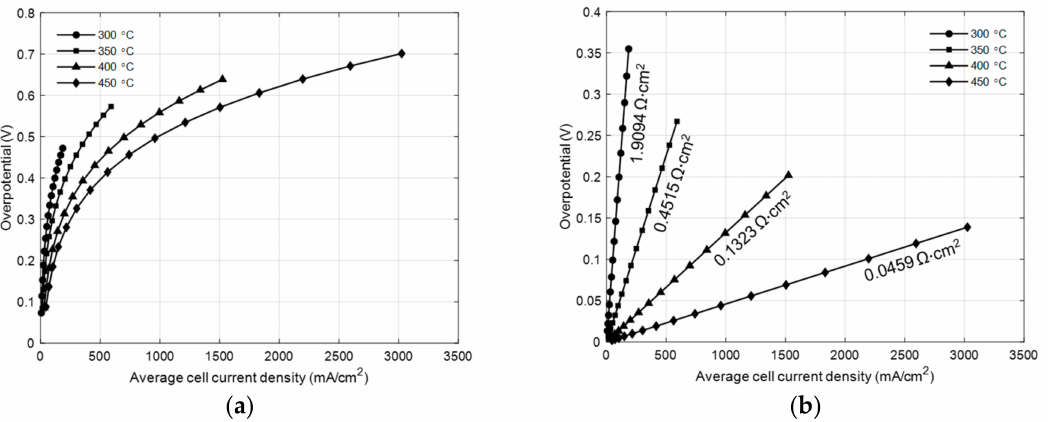
Figure 5. Overpotentials regarding the average cell current density at different operating temperatures. ( a ) activation overpotentials; and, ( b ) ohmic